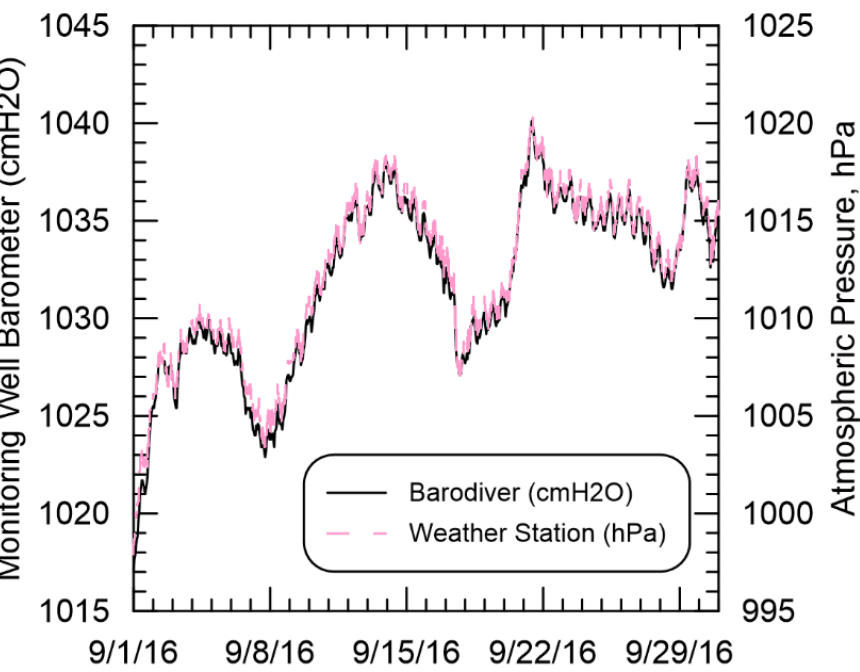
Figure 5. Atmospheric pressure recordings for the month of September 2016 from a monitoring well barometer as well as the nearest weather station.